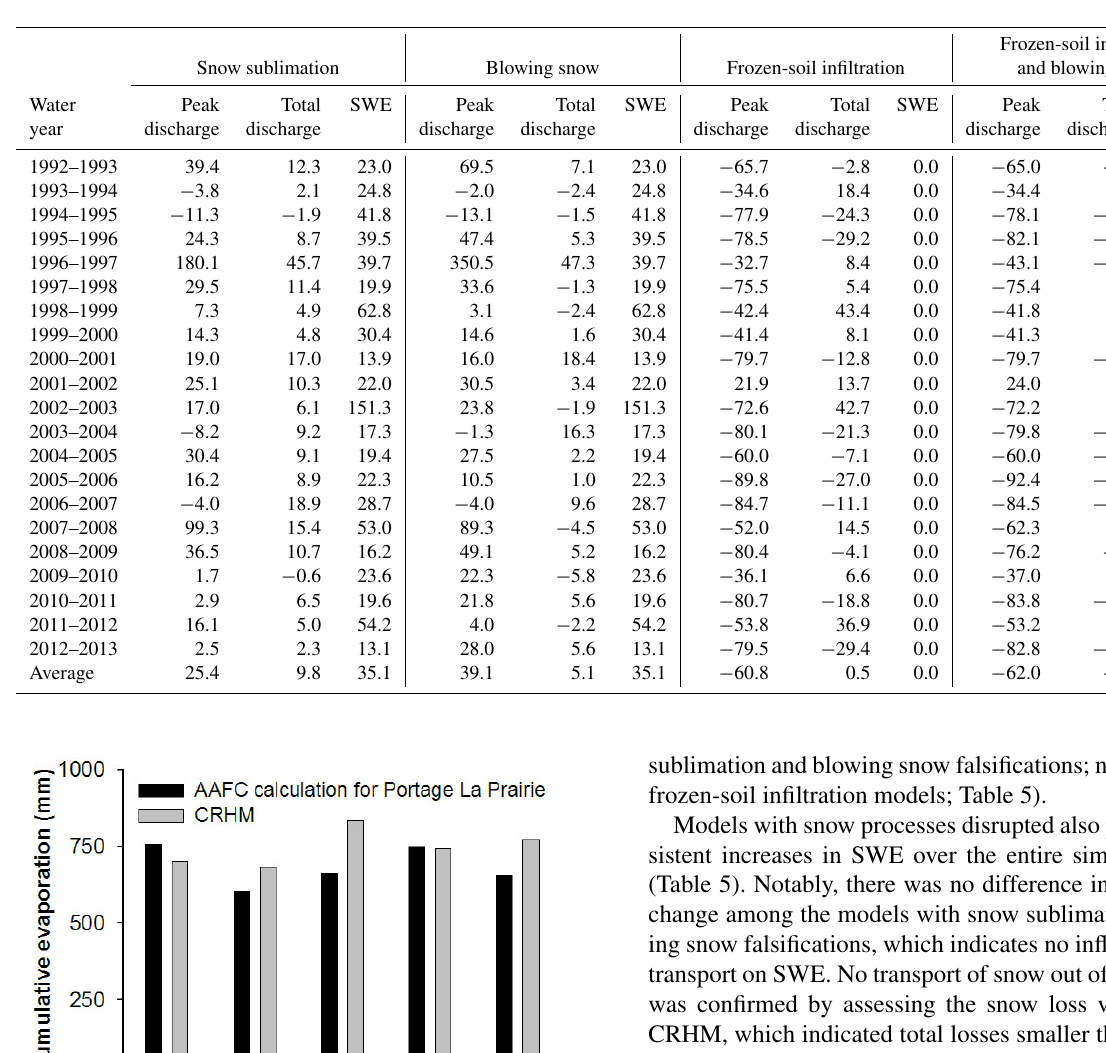
Table 5. Percent change in peak discharge, total discharge, and snow water equivalent (SWE) between falsified models and base models.